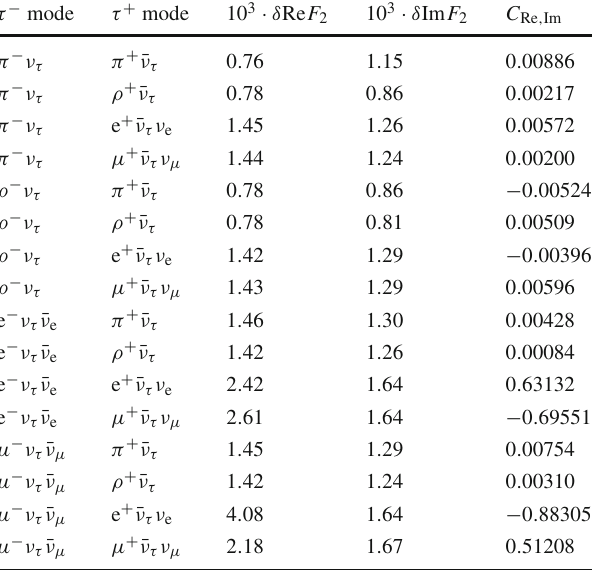
Table 1 Results obtained from 10 6 simulated events for the resolution of Re F 2 and Im F 2 in the 16 possible combinations of decay channels, and the correlation coefficient C Re , Im between real and imaginary part of F